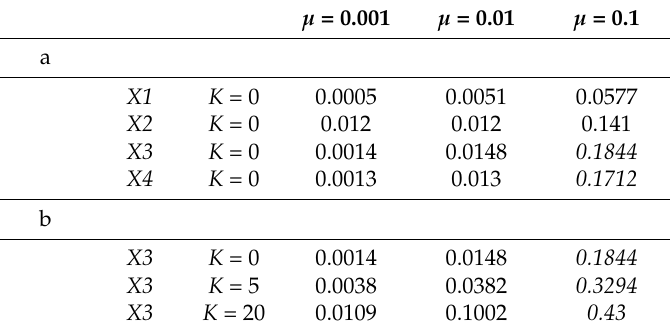
Table 3. Average amount of executed C actions per PD game ( C ) found in populations at equilibrium, r as a function of mutation rate. The top row gives mutation rates, first column the Xr sets, and second column the background fitness values K . Part a: varying strategy set for K = 0; part b: varying background fitness for strategy set X3 . The C -values from equilibrium populations in which non-defectors obtain r above average fitness are given in italic. Fixed parameters: P = 1, T = 5, S = 0, R = 3. µ = 0.001 µ = 0.01 µ =